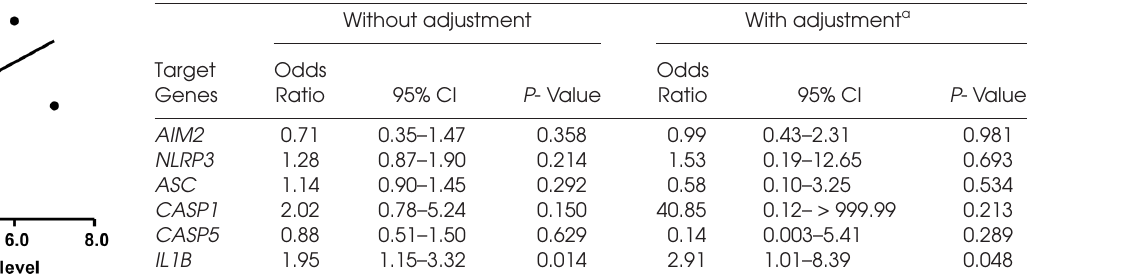
Table 4. Conditional logistic regression to identify independent risk factors for